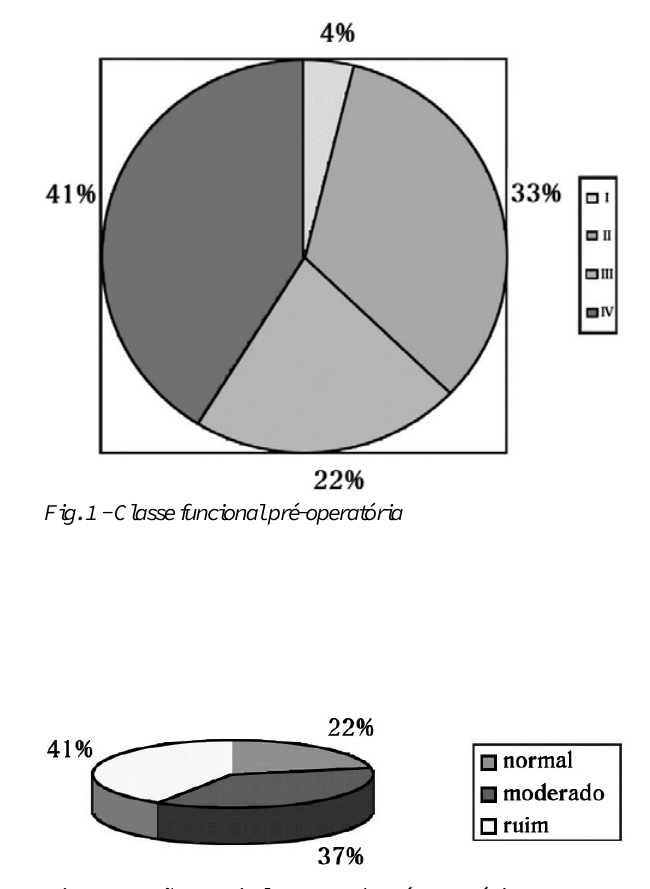
Fig. 2 - Função ventricular esquerda